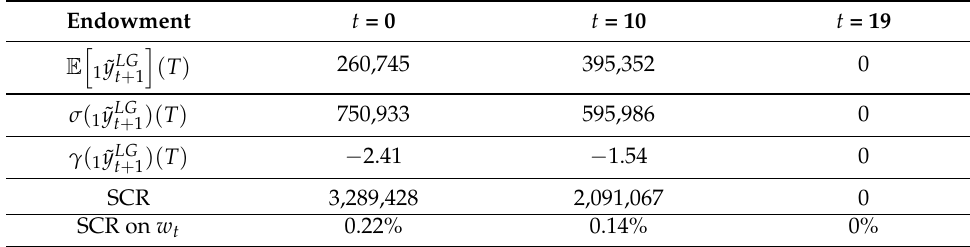
Table 7. Local GAAP